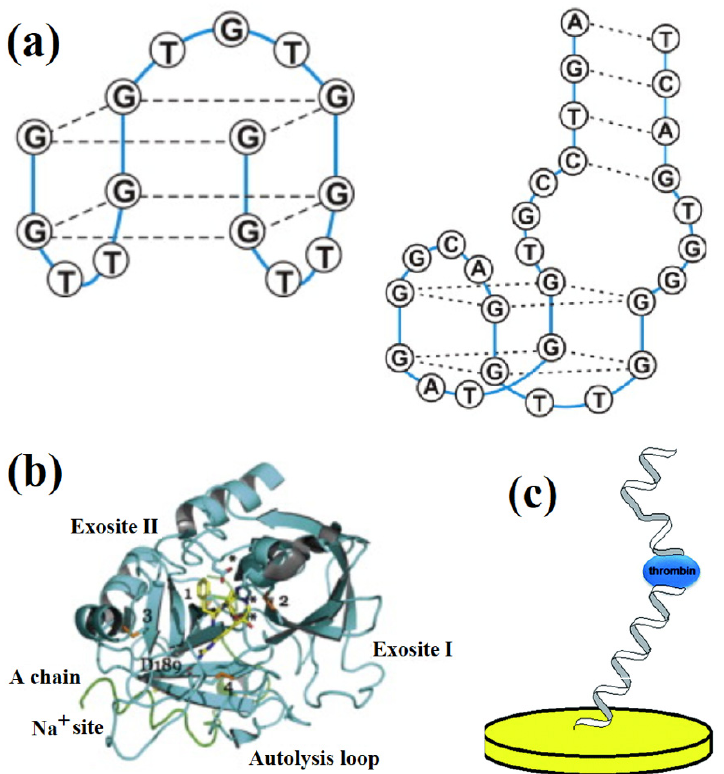
Figure 3. ( a ) G-quadruplex structure of Apt15 and Apt29, and ( b ) binding sites of thrombin. Adapted from [3]. ( c ) Sandwich assay setup utilizing both thrombin aptamers. Adapted from [61].